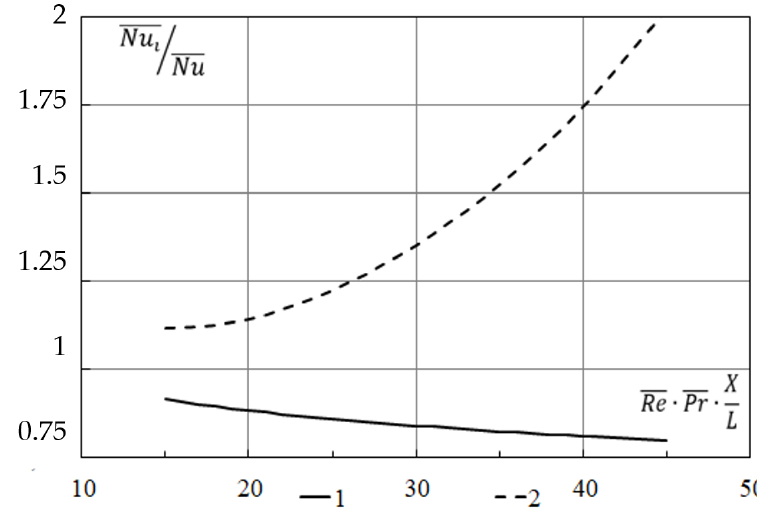
Figure 15. Dependence of relative Nusselt numbers on the dimensionless coordinate. Curve 1—one– sided heat input, hot surface; curve 2—one-sided heat input, non-heated surface.